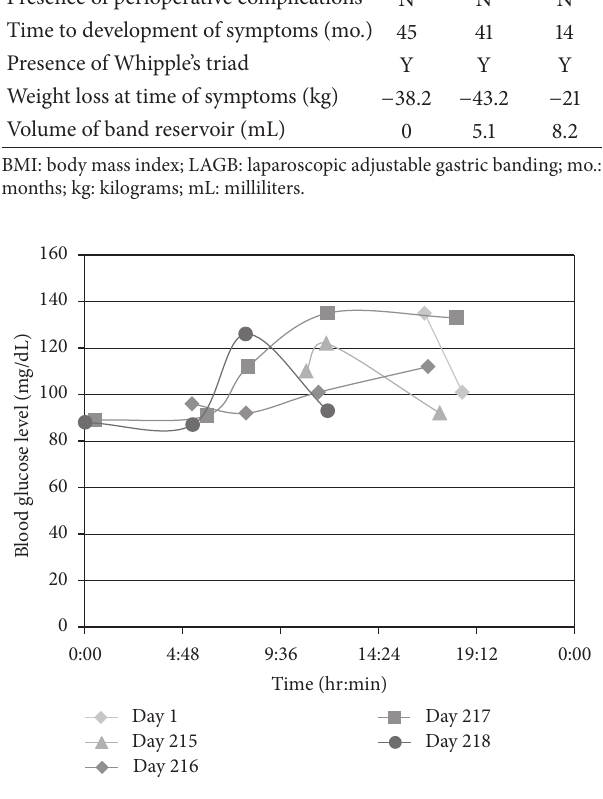
Figure 1: Trend in nonfasting blood glucose level of a single patient with